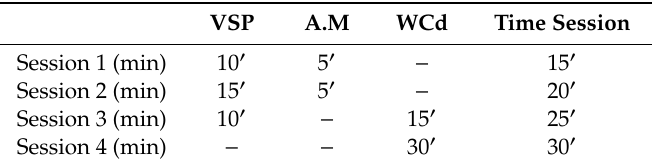
Table 2. Gait retraining protocol a .